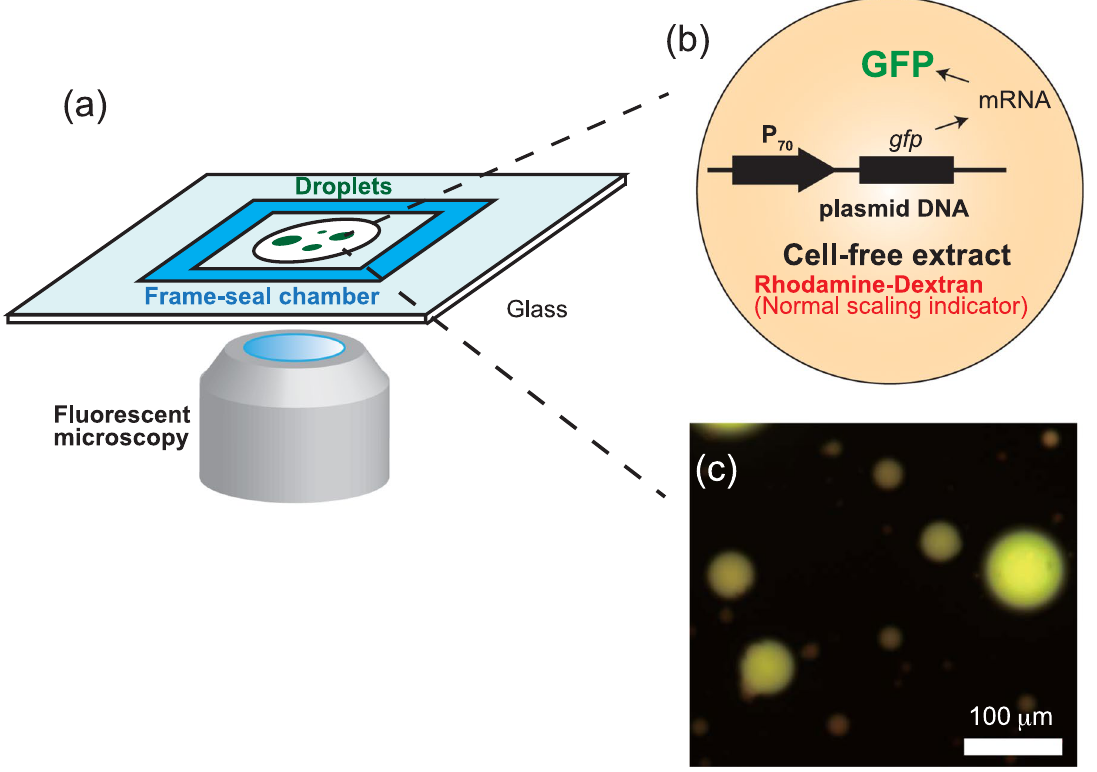
Figure 1. ( a ) Schematic illustration of experimental setup. Emulsion droplets containing the TXTL reaction and plasmid DNA are recorded in multi-color fluorescent microscopy. ( b and c ) The product of TXTL, deGFP, was observed in green fluorescent channel while Rhodamine-dextran as normal scaling indicator was visualized in red-fluorescent channel. Scale bar: 100 μ